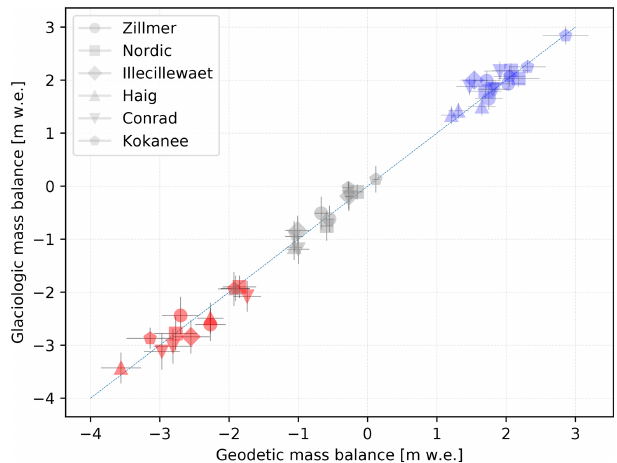
Figure 5. Geodetic versus glaciological mass balance estimates for 2015 through 2018 for all six study glaciers with a one-to-one line. Blue shows the winter balance covering the accumulation season from mid-September to late April; red shows the summer balance spanning the remaining months; gray shows the annual balance. Er- rors depicted are 1 σ uncertainties. Average B w_glac was 4% greater than B w_geod , and B s_glac and B a_glac were 3% smaller and 3% larger, respectively, than our geodetic